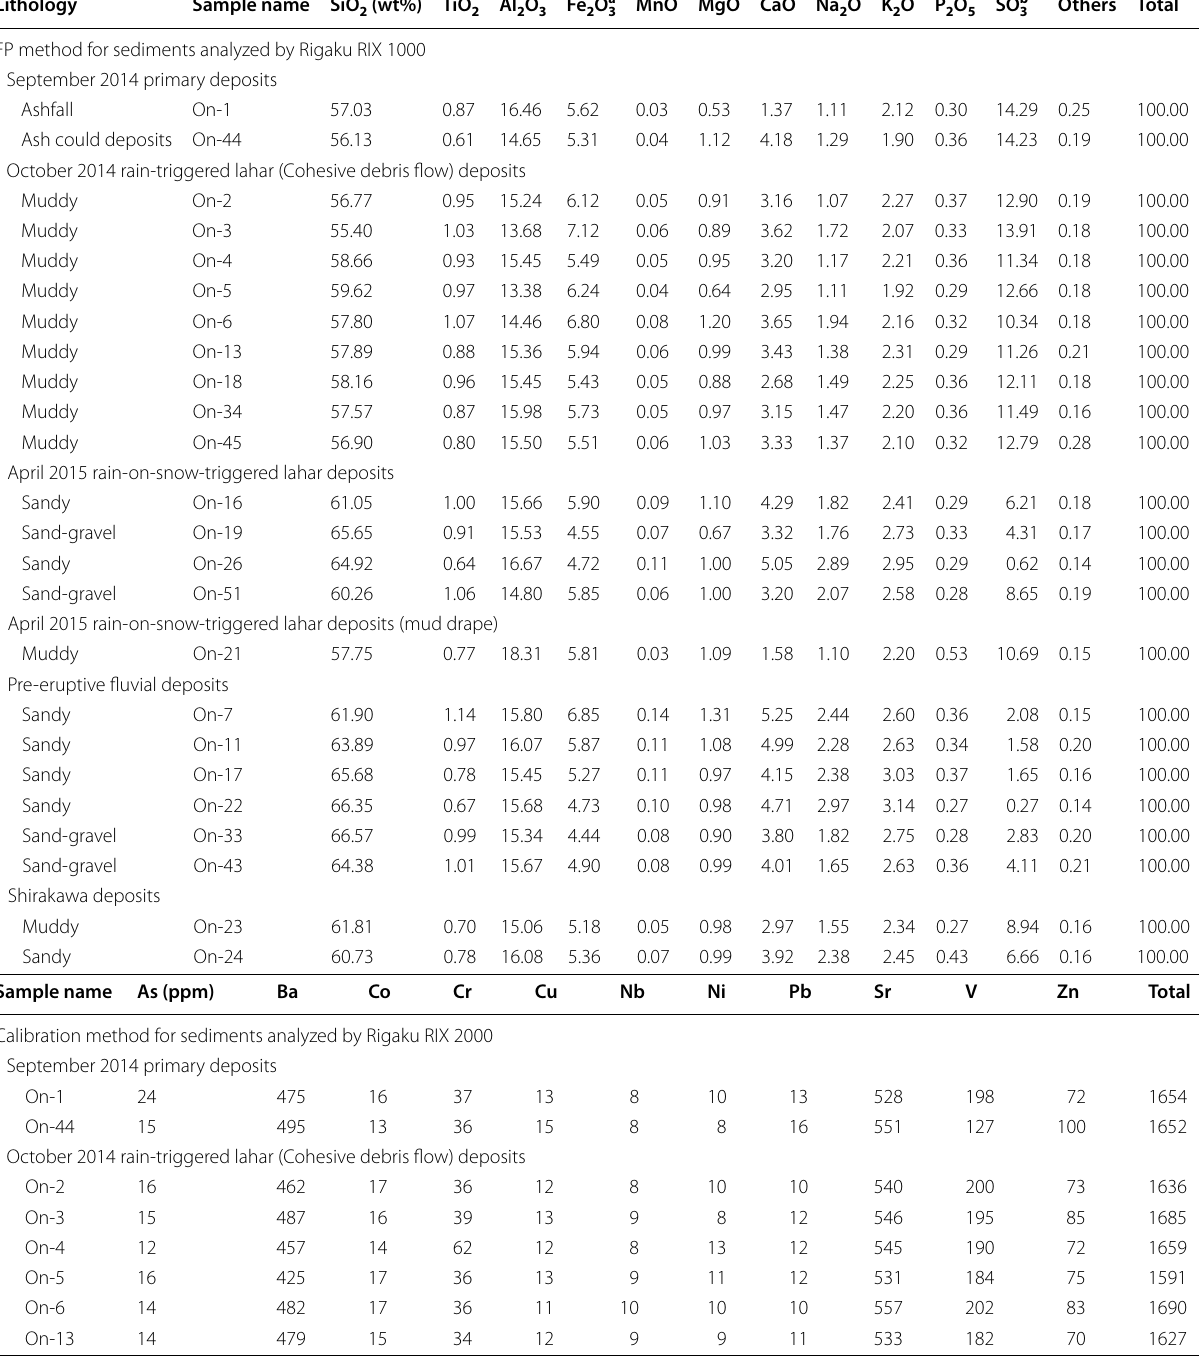
Table 4 Results of XRF (bulk chemistry) of ashfall, rain‑triggered lahar and ROS‑triggered lahar deposits, and pre‑ eruptive fluvial deposits